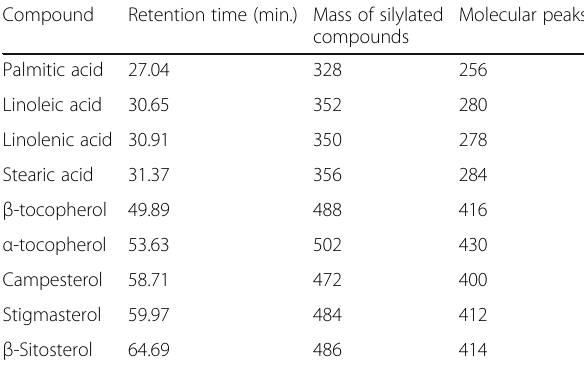
Molecular peaks compounds